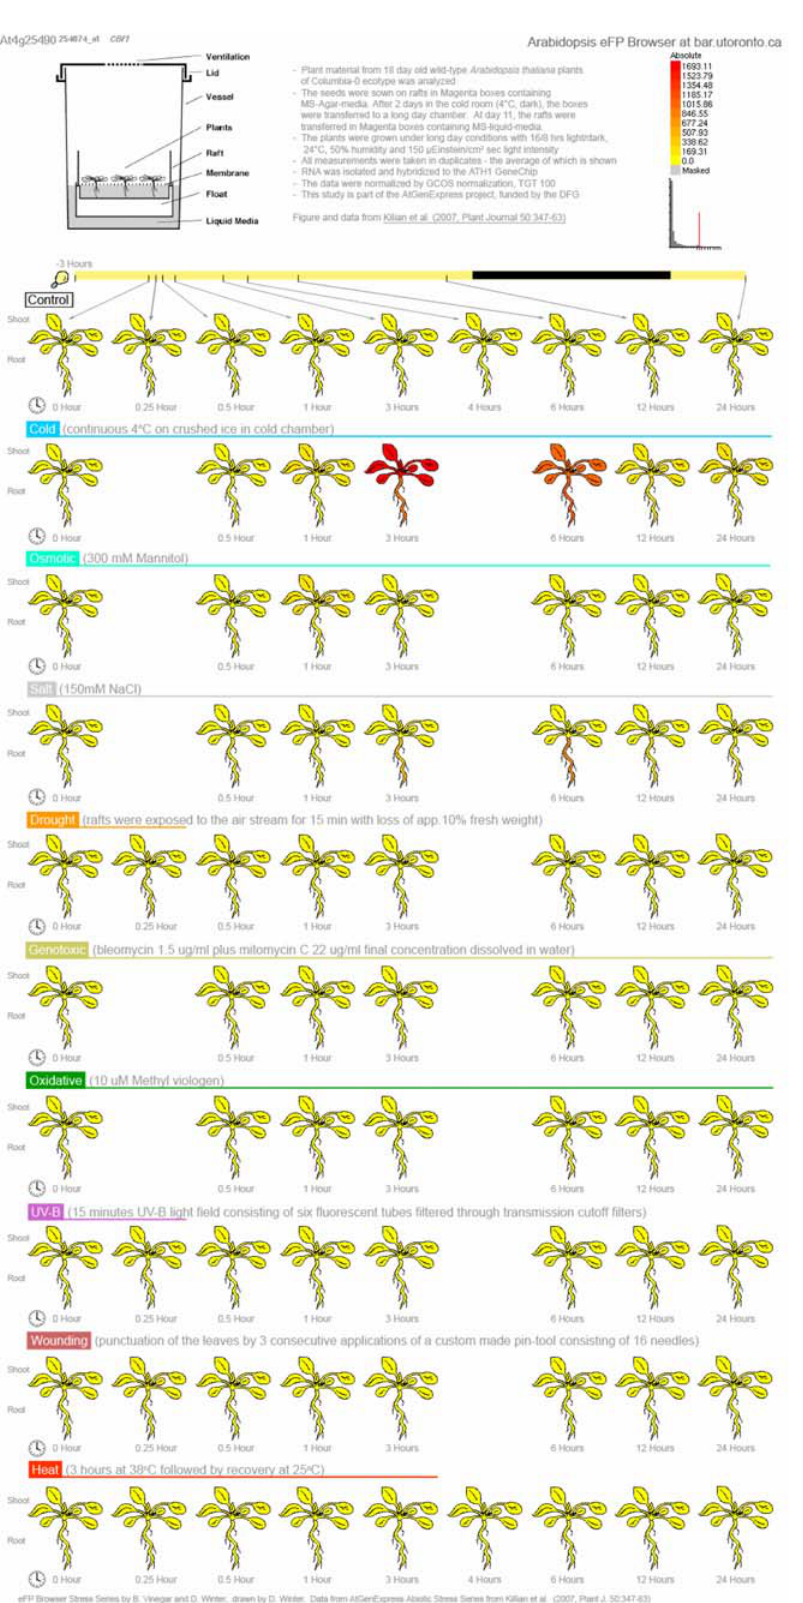
Figure 4. Abiotic stress response for the cold-inducible transcription factor gene C-BOXBINDINGFACTOR1, At4g25490, as viewed with the Arabidopsis eFP Browser.